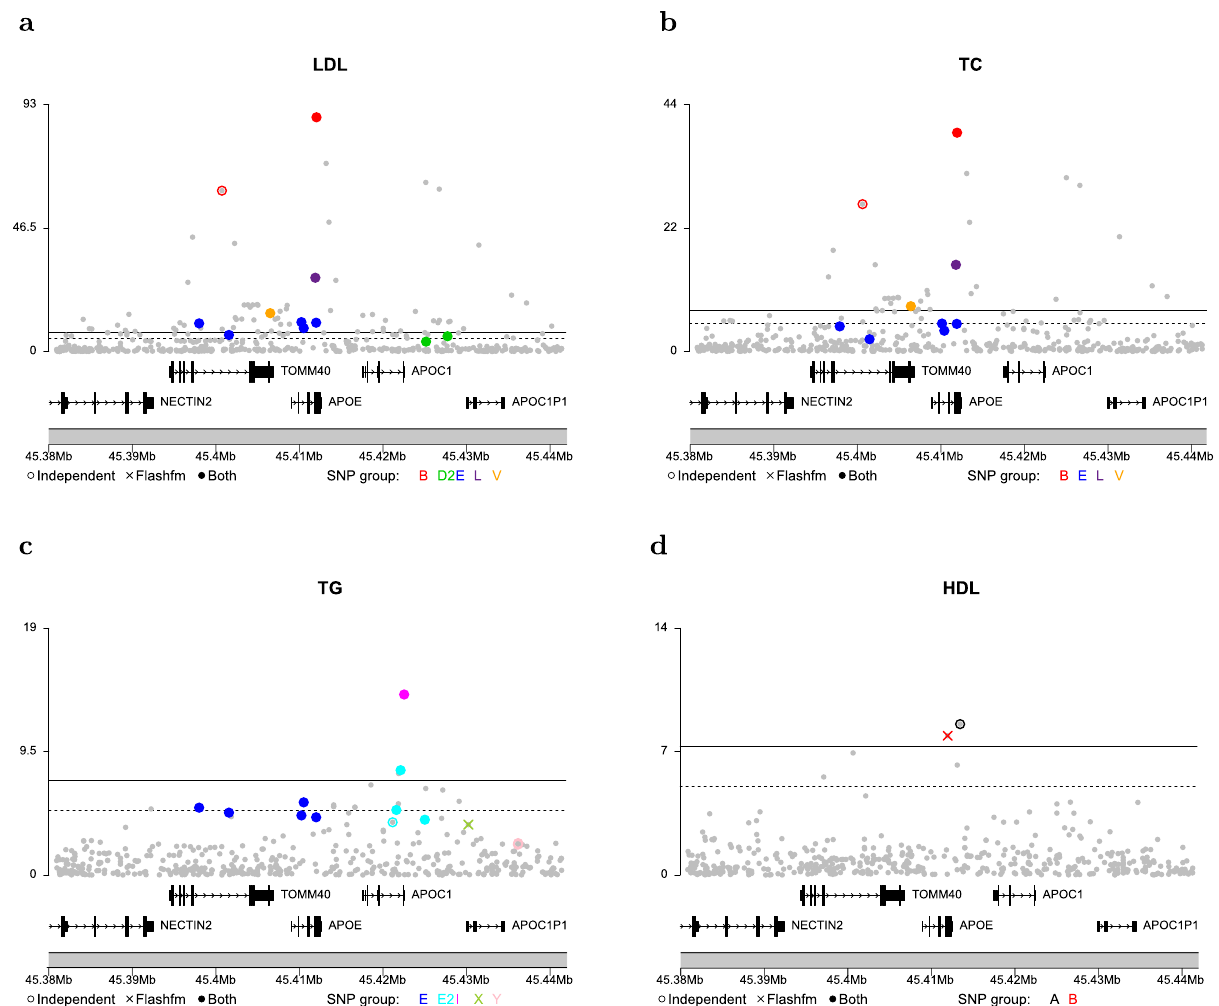
Fig. 3 Fine-mapping of signals for four lipid traits in region 19:45380937-45441453. The -log 10 p for SNPs in the top SNP groups for a LDL; b total cholesterol (TC); c triglycerides (TG); d HDL are shown for both FINEMAP and fl ashfm. The two methods agree on a 5-SNP model for LDL ( a ) and a 4-SNP model for TC ( b ). The top model for TG ( c ) has 4 SNPs under both methods but differ in one SNP group; FINEMAP prefers 3-SNP group Y (very near one another so appear as one) and fl ashfm selected single SNP group X (mean r 2 of SNPs in Y with X is 0.315). For HDL ( d ), a different single-SNP model was selected by the two methods; FINEMAP favoured group A, whereas fl ashfm selected group B. The solid coloured circles show SNPs that belong to the SNP groups constructed by both methods, the empty coloured circles represent SNPs that are only in the FINEMAP SNP group; solid grey circles show all other SNPs in the region. In c and d an X represents a SNP that appeared in a top model for fl ashfm and not FINEMAP and empty circles indicate SNPs that appeared in top models for FINEMAP and not fl ashfm. Position is given according to hg19/build 37. Some of the genes in this region include APOE, APOC1 and